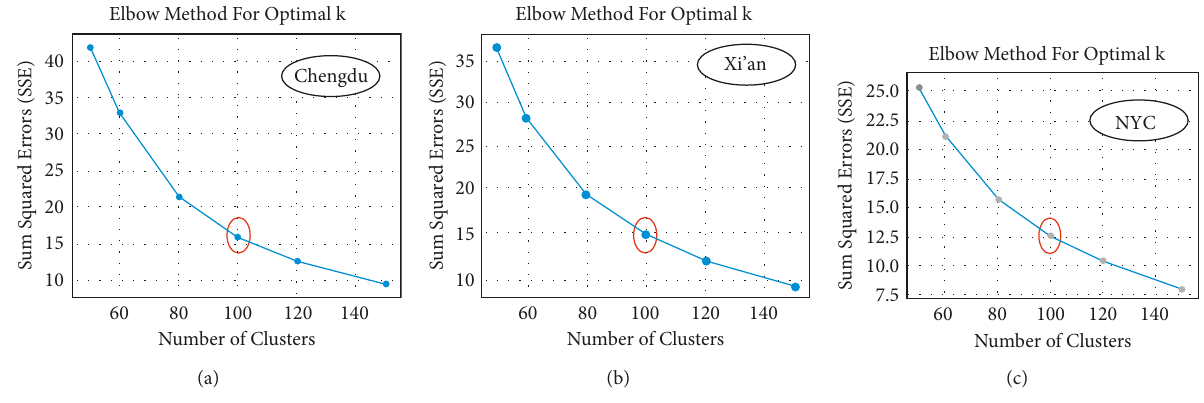
Figure 2: Investigation of selecting K-means clustering value using elbow curve method. Table 2: Weather data formalization and